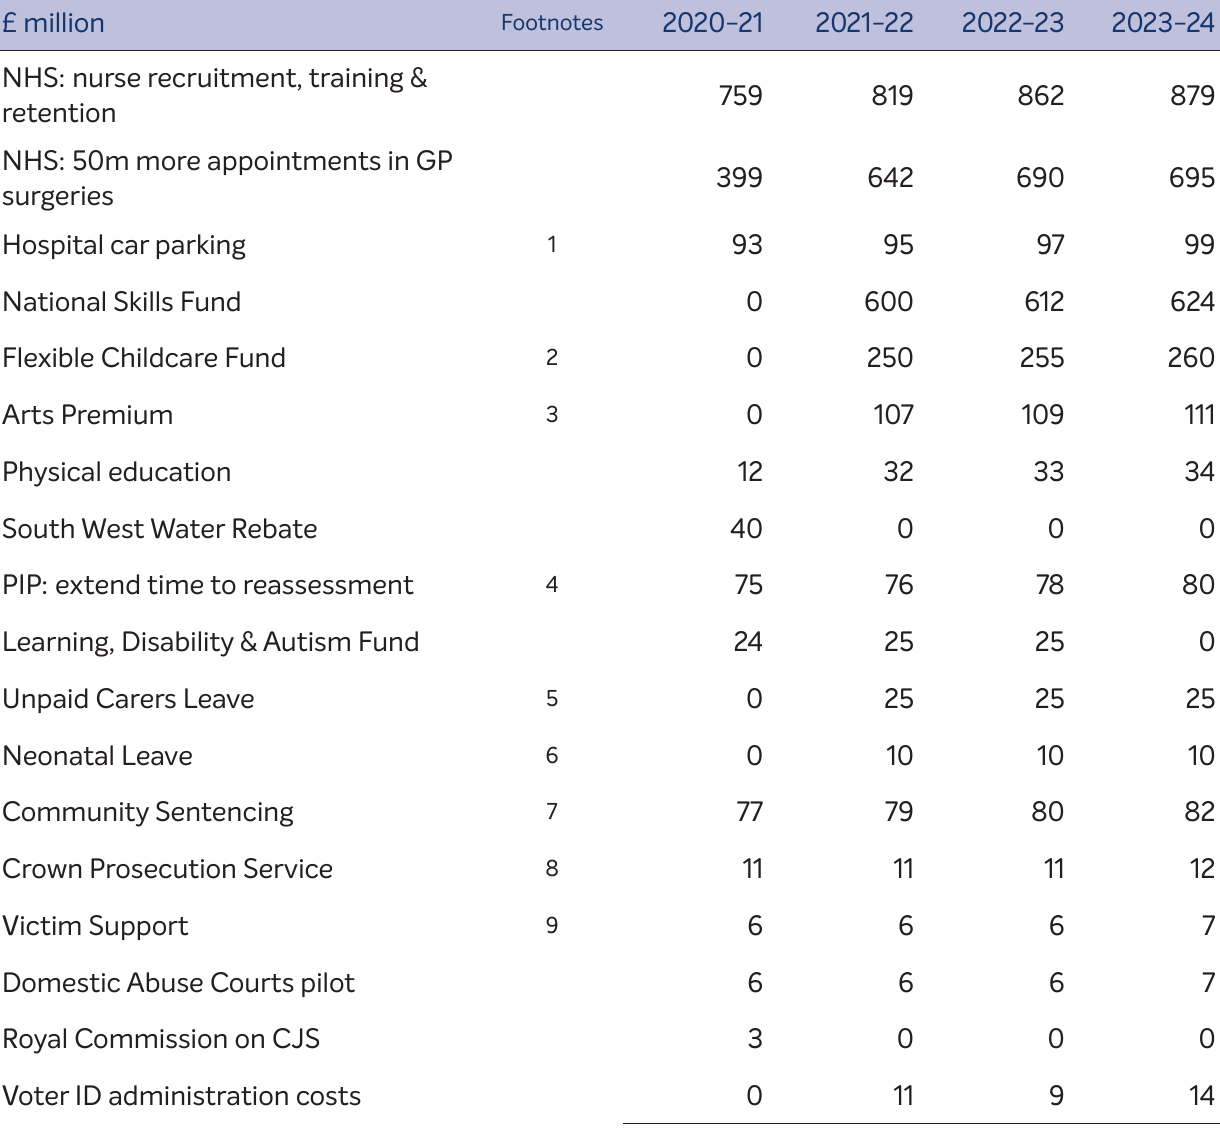
Table 1: Resource